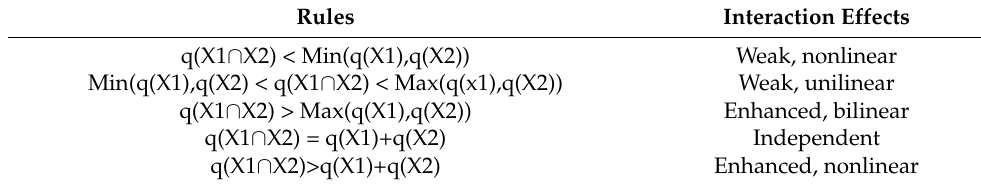
Table 1. Criteria of interaction